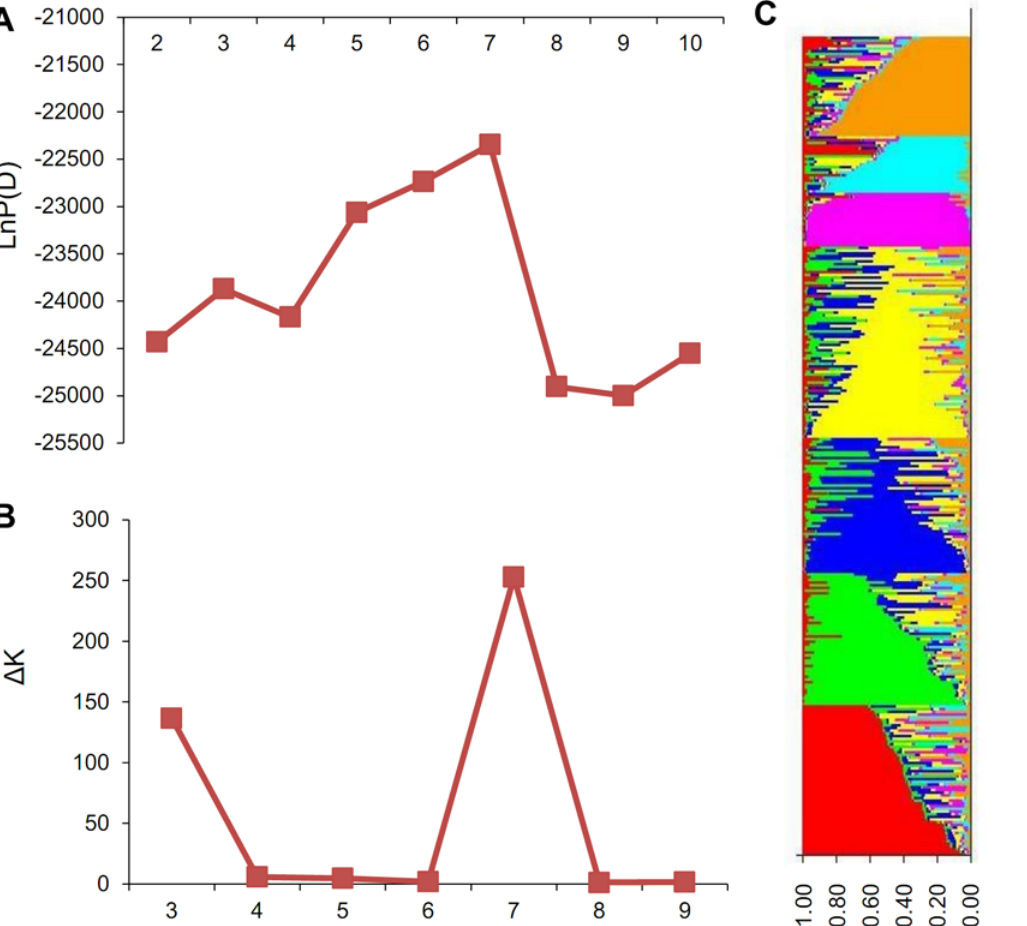
Fig 1. Population structure analysis in 304 cotton cultivars/accessions. (A) The most likely number of clusters (K) by LnP(D) analysis; (B) The most likely number of clusters (K) by Δ K analysis; (C) Population structure in 304 cotton cultivars/accessions (K =